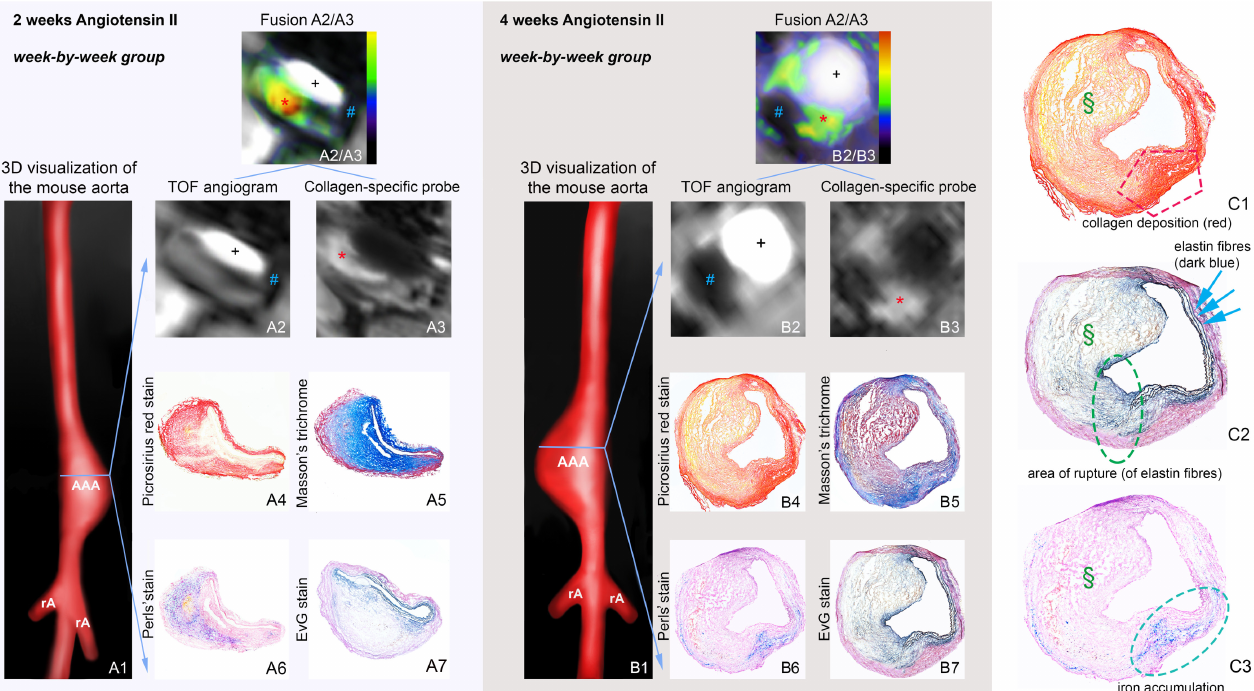
Figure 1. Molecular MRI (in vivo) using collagen- and inflammation-specific probes. ( A1 , B1 ) show 3D visualizations of 2- and 4-week-old AAAs. ( A2 , B2 ) show examples of oxide MRI with signal voids of different sizes for 2-week ( A2 ) and 4-week ( B2 ) AAAs. IR T1-weighted sequences show areas of intermediate signal enhancement of 2 weeks ( A3 ) and four weeks ( B3 ) AAA. ( A4 – A7 ) and ( B4 – B7 ) correspond to ex vivo histological measurements using Picrosirius red and Masson’s trichrome for visualization of collagen fibers and Perls’ staining for detection of inflammation-associated iron, confirming in vivo findings. ( C1 ) illustrates compensatory collagen deposition in the aneurysmal wall after rupture. ( C2 ) indicates the rupture site (green circle) with the ruptured elastin fibers and ( C3 ) demonstrates iron accumulation at the rupture site. * Signal from the collagen-binding probe in the aneurysmal wall, # Signal void from the iron oxide particles, § Thrombus area. AAA suprarenal abdominal aortic aneurysm, rA renal artery, + Vascular lumen in arterial TOF. This figure was originally published in Adams et al., [21] (open access article, distributed under the terms of the Creative Commons Attribution